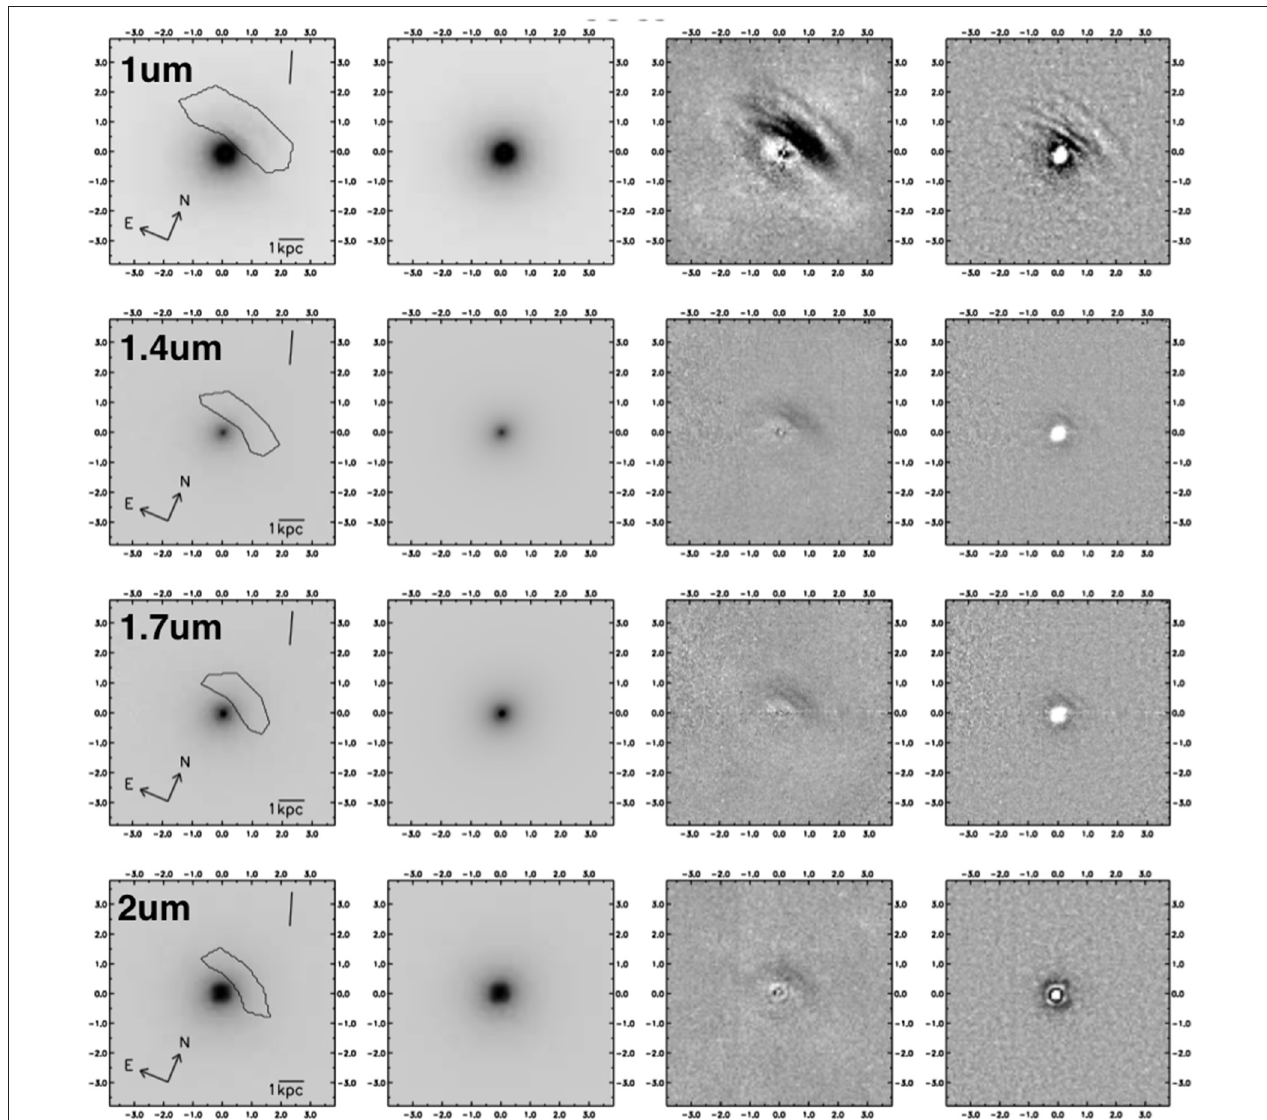
FIGURE 2 | HST residuals after galaxy model subtraction: the case 3C 33. From top to bottom row: 1.0, 1.4, 1.7, and 2.0 µ m. Field of 7.6 × 7.6 acsec size. The line in the upper-right corner represent the orientation of the inner radio jet. Contours represent a masked region where traces of dust lane are detected—excluded for the fit. The images are shown in gray linear